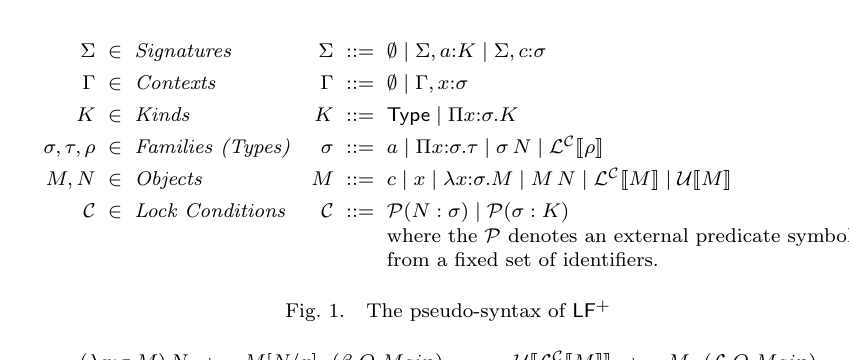
Fig. 2. Main one-step- β L -reduction rules